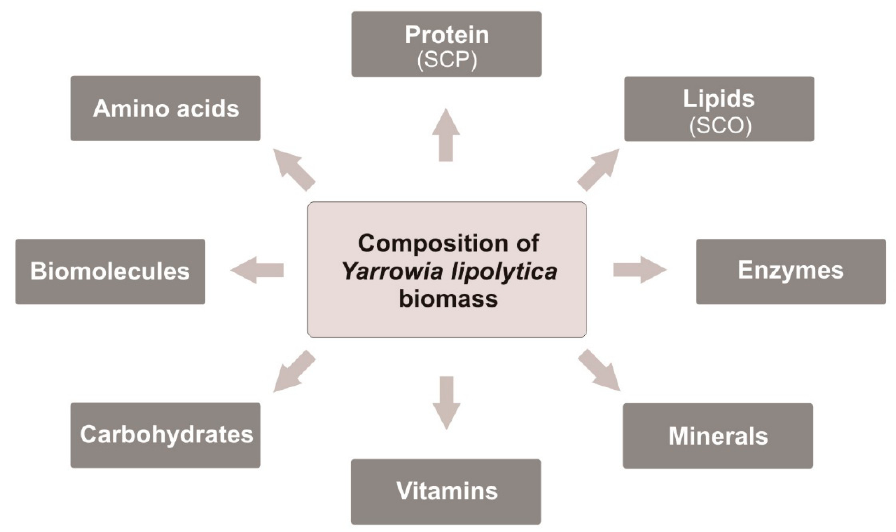
Figure 1. Composition of Yarrowia lipolytica